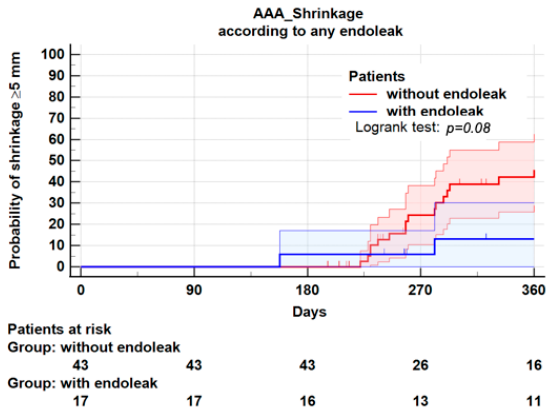
Figure 3. Kaplan–Meier plot for occurrence of sac shrinkage according to endoleak. Shrinkage at 1 year was 46.1 ± 8.0% in patients without endoleak, and 13.0 ± 8.0% in patients with any type of endoleak, p = 0.08.